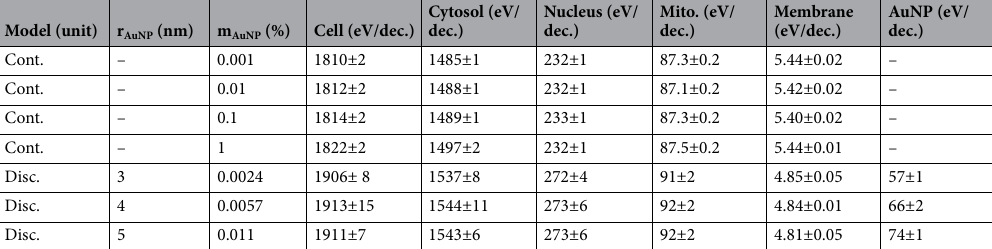
Table 1. Energy deposit per decay (dec.) in the cell organelles for continuous (Cont.) and discrete-geometric (Disc.) models. Energy deposit in the cell and cytosol include the energy deposit in the AuNP. Energy deposit values for mitochondria (Mito.) and AuNP are given as sum over all objects.